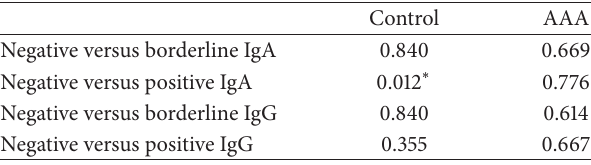
Table 5: Comparison of C-reactive protein levels with IgA and IgG antichlamydial antibody titres within the control and the AAA groups.Thenumbersinthetablerepresent 𝑃 values(Mann-Whitney 𝑈 test).